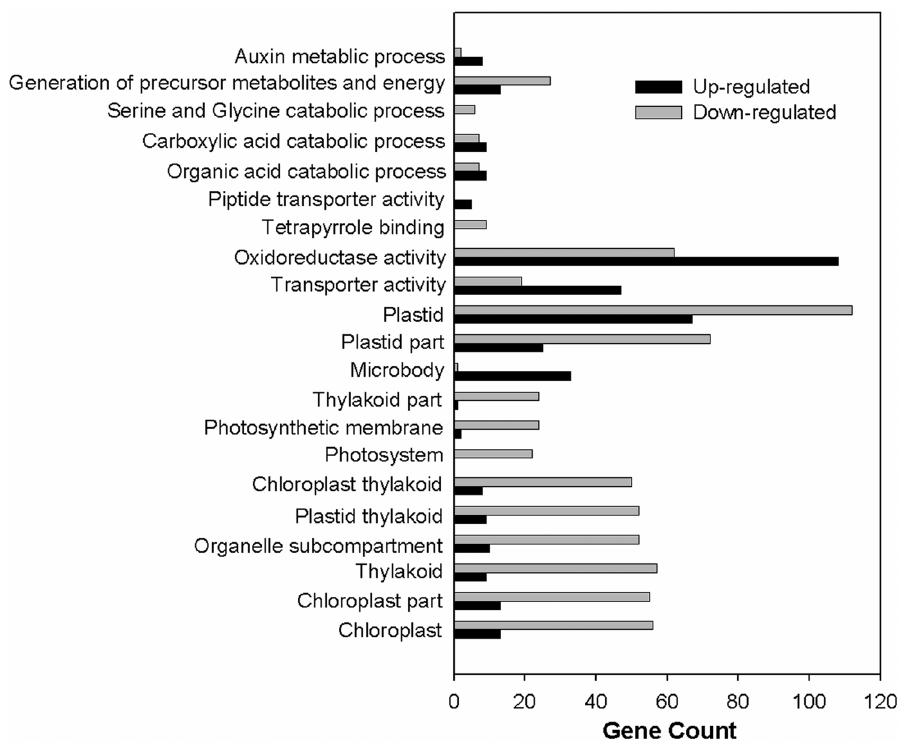
Figure 1. GO analysis of differentially expressed genes obtained from Solexa sequencing. The abscissa of the bar plot represents the gene count within each GO category. All processes listed had enrichment p values , 0.05. (Table 4, 5). Eight WRKY and 3 R2R3-myb TFs along with 5 of the 6 differentially expressed ERF TFs were up-regulated in K1 compared with K2. Interestingly, the 11 differentially expressed NAC domain proteins were all up-regulated in K1 compared with K2, suggesting that NAC domain proteins may have important roles in cotton leaf senescence (Table 5).